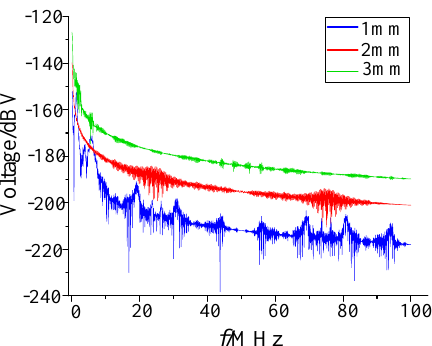
Figure 20. Frequency domain distribution of induction voltage in the 3.3 V power line.